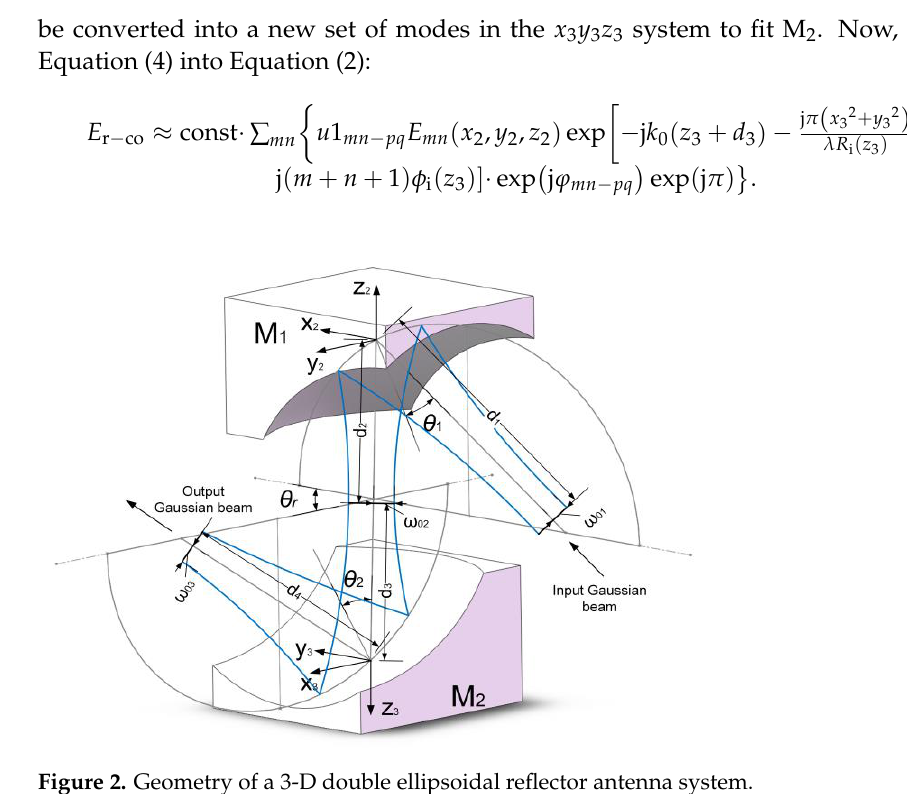
3 of 13 Figure 1. Geometry of an off-axis ellipsoidal mirror with the input and output beams in the local coordinate systems. 𝐸 i−co = 𝐸 𝑝𝑞 exp [−j𝑘 0 (𝑧 1 + 𝑑 1 ) − j𝜋(𝑥 12 +𝑦 12 ) 𝜆𝑅 i (3) Here, 𝐸 i−co is the co-polarization of the incident field linearly polarized in the 𝑦 di- rection, 𝐸 r−co and 𝐸 r−cx are the co- and cross-polarization of the reflected field, respec- tively. 𝐸 𝑝𝑞 represents the amplitude of (𝑝, 𝑞) order Hermite-Gaussian mode. The expo- nential term in (1) is the phase of (𝑝, 𝑞) order Hermite-Gaussian mode. In (2) and (3), 𝑢1 and 𝑢2 are coefficients of co-polar modes and cx-polar modes, respectively. The last two exponential terms exp(j𝜑) and exp(j𝜋) are additional phases to ensure the phase match- ing and phase reversal of the incident and reflected beams on the mirror according to the reflection theorem. And the subscript 𝑚𝑛 − 𝑝𝑞 means that the reflected (𝑚, 𝑛) mode is generated by the incident (𝑝, 𝑞) mode. The expressions of 𝑢1 , 𝑢2 , and 𝜑 were given in [21]. 𝑘 0 is the wavenumber. 𝑑 1/2 is the distance between the beam waist 𝜔 0_i/0_r and the center of the mirror. 𝑅 i/r and 𝜙 i/r are the radius of curvature and the phase slippage,